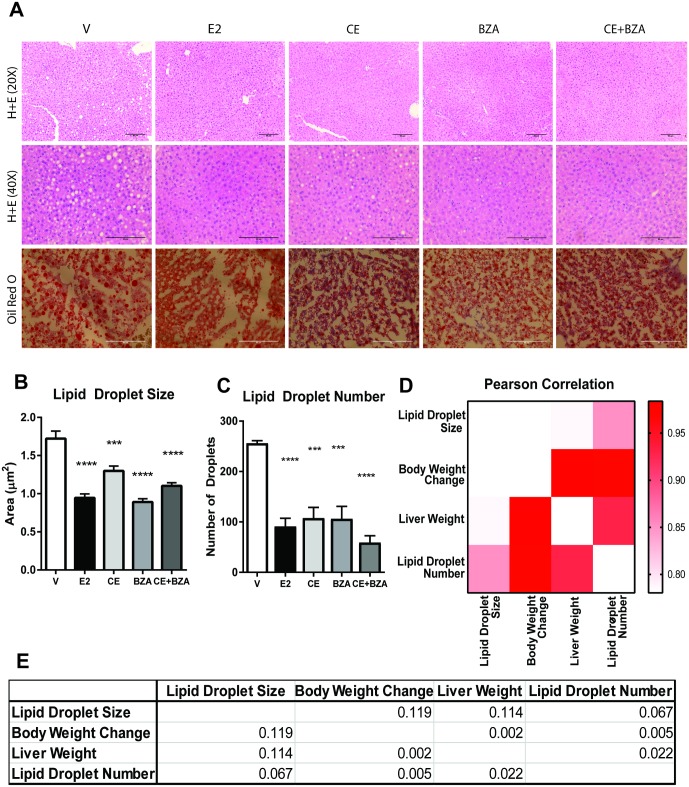
Lipid accumulation is decreased in mouse liver tissue after CE+BZA treatment.(A) H+E and Oil Red O staining of liver tissue from ovariectomized animals treated with various estrogens. Quantification of lipid droplet size (B) and number (C) by Fiji software. (D) Pearson correlations for lipid droplet size, body weight change, liver weight, and lipid droplet number were calculated. Statistical significance was established at α = 0.05. Pairwise t tests with a Bonferroni correction were used to identify treatments that were significantly different from Veh (***P <0.001, ****P<0.0001).